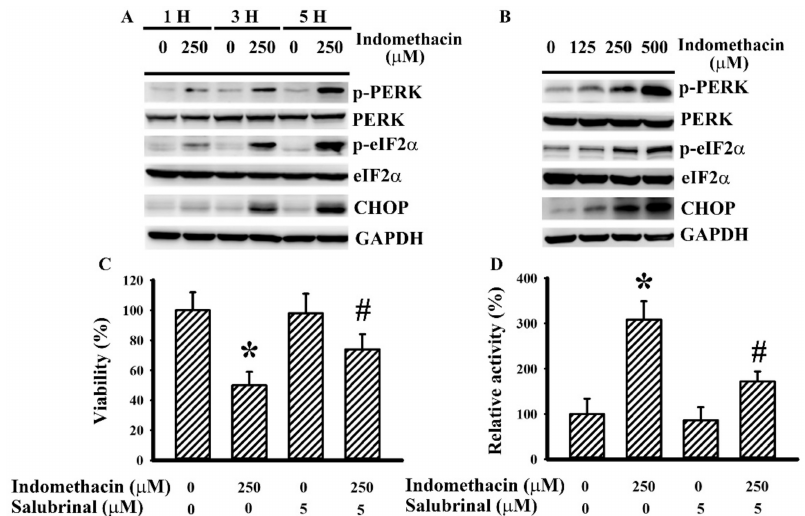
Figure 1. Indomethacin induced endoplasmic reticulum (ER) stress in H4 cells. H4 cells were treated with indomethacin (0 and 250 µ M) over time ( A ). H4 cells were treated with various concentrations of indomethacin (0–500 µ M) for 5 h ( B ). Proteins were isolated and subjected to Western blot with indicated antibodies. Representative blot of three independent experiments is shown. H4 cells were treated with indomethacin (0 and 250 µ M) in the presence of salubrinal (0 and 5 µ M). Cell viability (24 h) was assessed by MTS reduction assay ( C ). Caspase 3 activity (5 h) was assessed by enzymatic